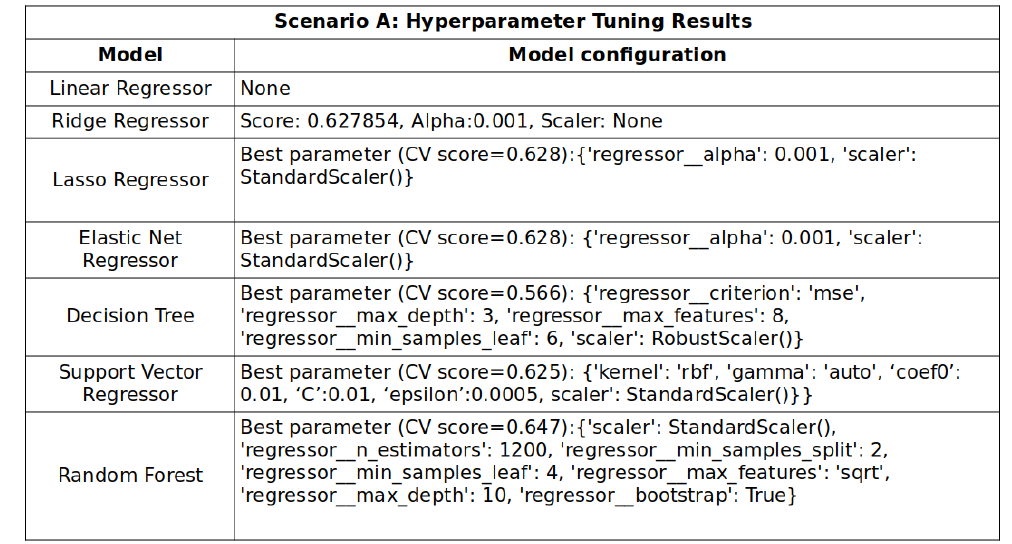
Figure A1. Hyperparameter configuration for the models of Scenario